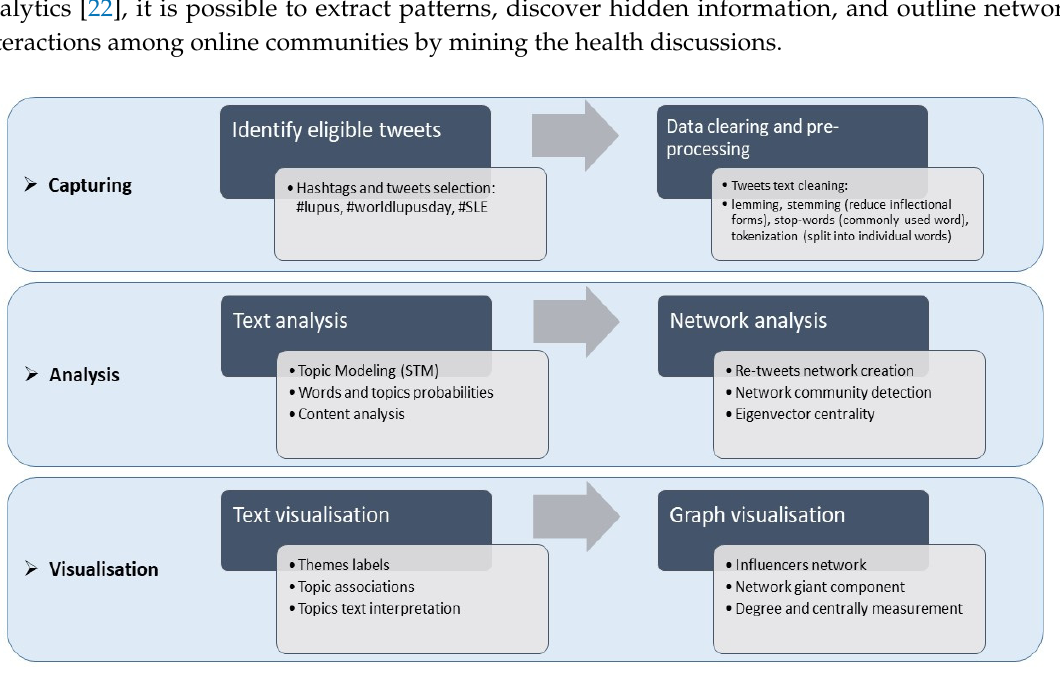
Figure 1. Framework workflow of social media Twitter analysis.